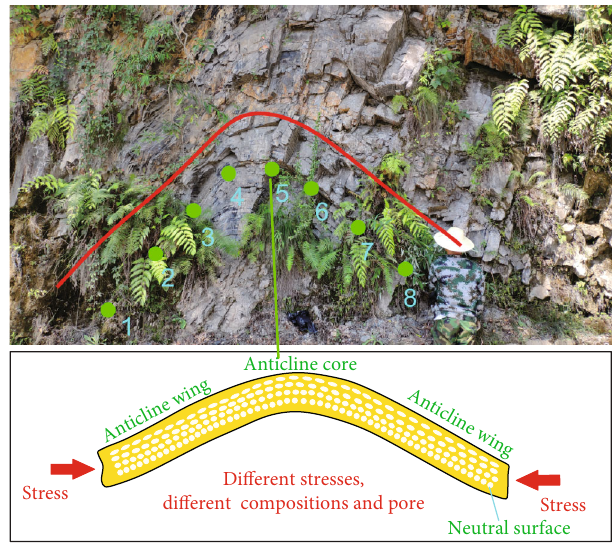
Stress Figure 9: Stress distribution pattern of di ff erent structural parts of anticline. Modi fi ed from Ramsay and Huber